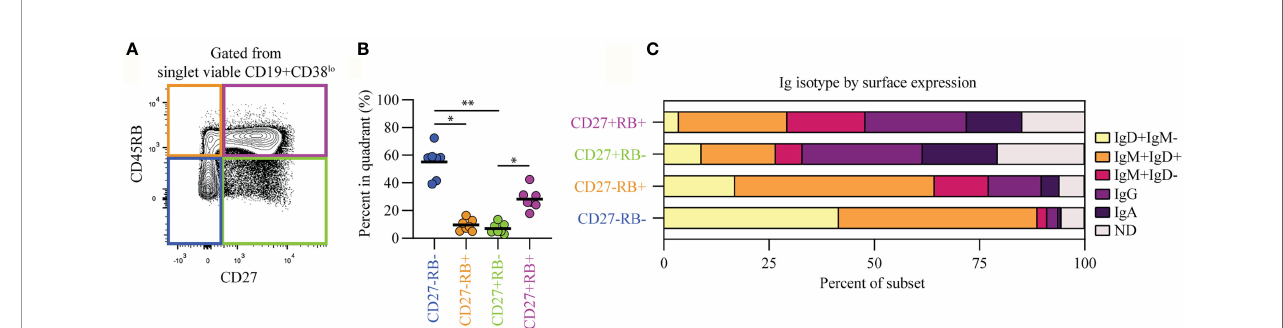
FIGURE 1 | B cells within subsets separated based on CD45RB glycosylation and CD27 expression feature differential Ig isotype usage. (A) Representative biaxial CD45RB/CD27 plot gated from singlet viable CD19+CD38 lo cells ( Figure S1A ). (B) Percent of B cells in each quadrant, as in (A) , for seven biological replicates (healthy adults) each composed of two technical replicates over three independent experiments. (C) I g -isotype usage per quadrant. ND, not determined. Black lines depict mean values. Statistical differences were determined using a Friedman analysis of variance and Dunn ’ s multiple comparison test. *p < 0.05, **p